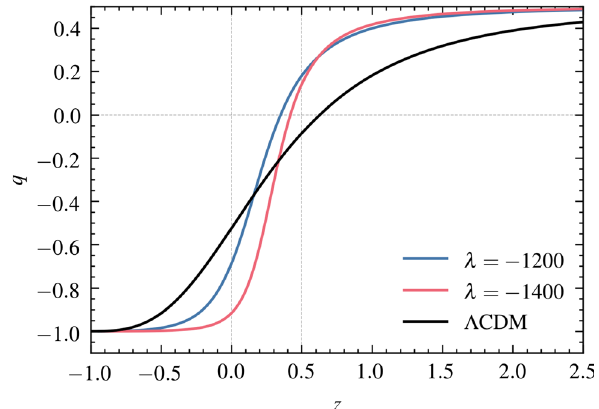
Fig. 2 Hubble parameter ( H ( z ) ) as a function of redshift ( z ) for differ- ent values of λ with standard Rényi HDE density (with (cid:12) m 0 = 0 . 315 and H 0 = 67 . 4 km/s/Mpc [78]). OHD corresponds to the Observational Hubble Data set with 57 entries [79]